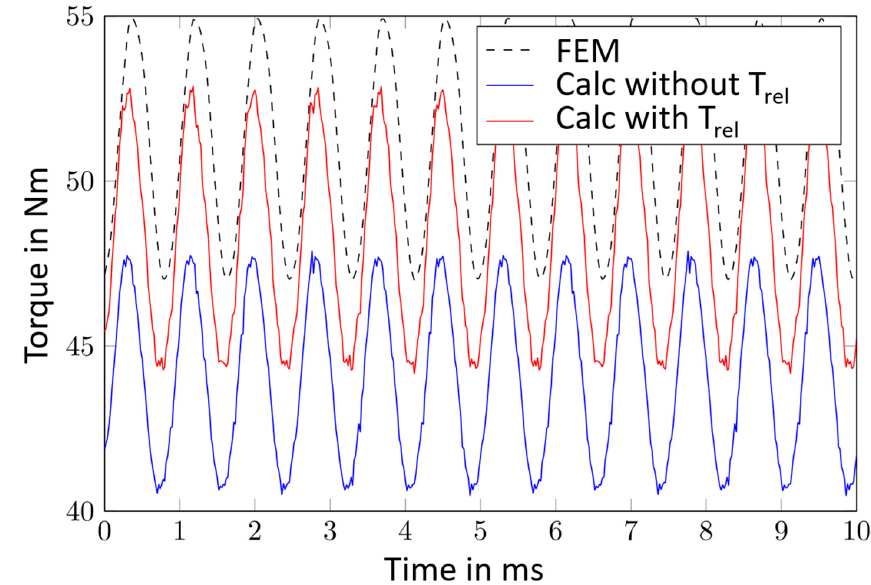
Figure 5. Time course of the torque for a selected operating point, resulting from the FEM calculation as well as from the analytical calculation with and without reluctance torque.